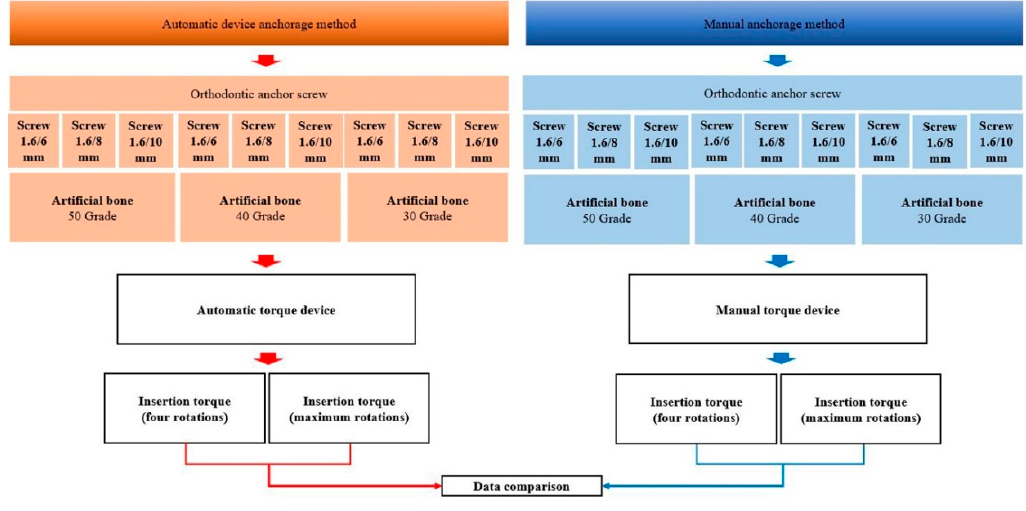
Figure 1. Overview of the experimental process.